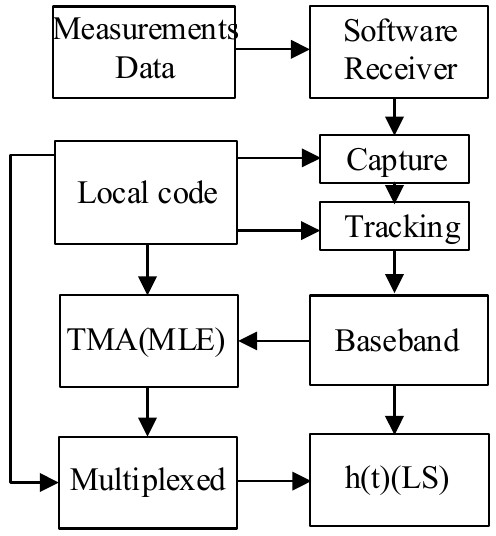
Figure 3. Joint estimation algorithm block.